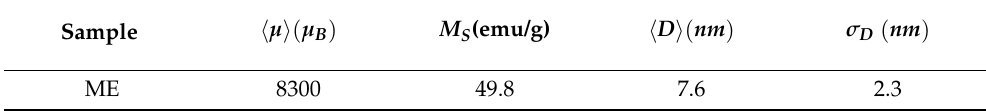
Table 1. Obtained parameters from Langevin fit performed on the cycle M vs. H. Mean